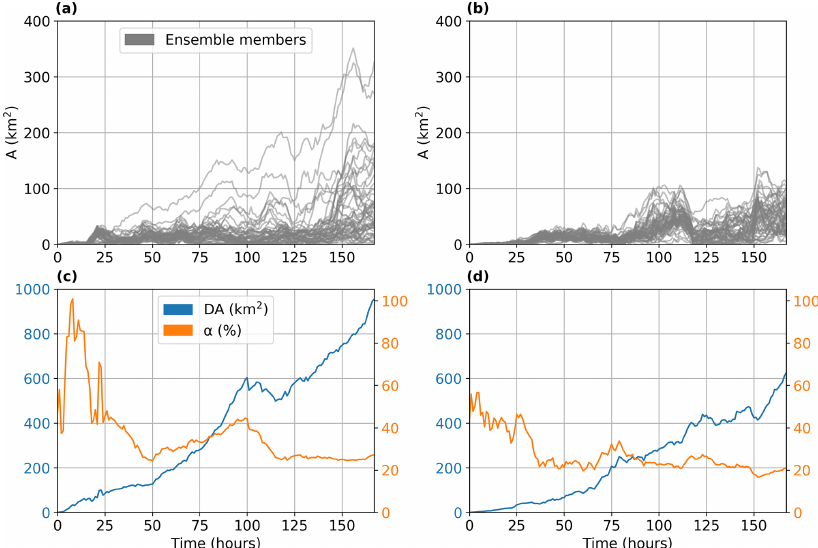
Figure 9. Area of the deterministic convex hull that exceeds the area of each member ( A in km 2 ; gray lines) for (a) winter and (b) spring as a function of the forecast time. DA extent (units in km 2 ; blue line) of the ensemble convex hull area with respect to the deterministic state and percentage of change, a (%; orange line), for (c) winter and (d) spring. Oil type: API 31.